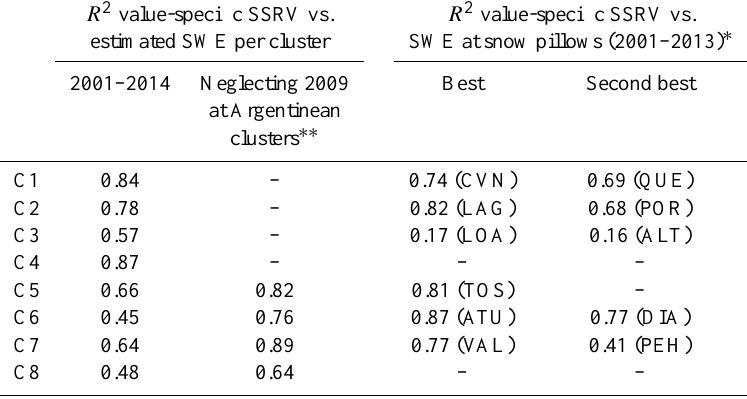
Table 5. Coefficient of determination R 2 between river melt season flows (SSRV) and estimated and observed SWE (end-of-winter). R 2 value-specific SSRV